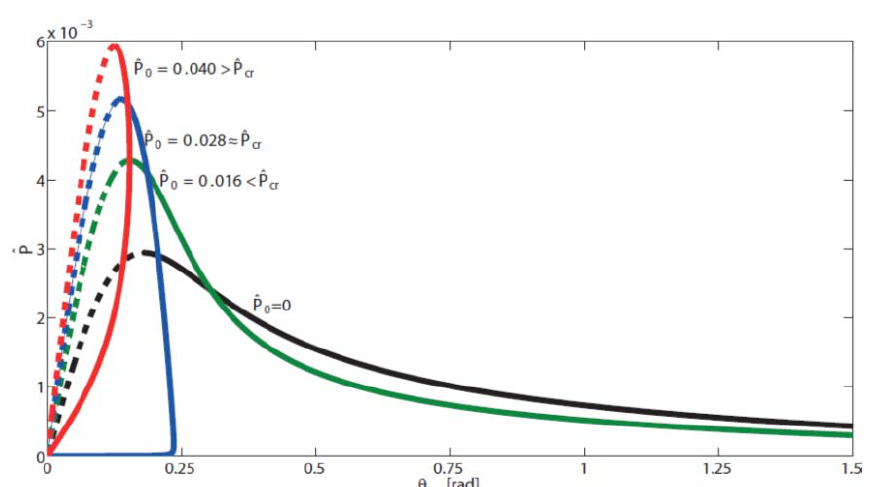
 for different values of the eq